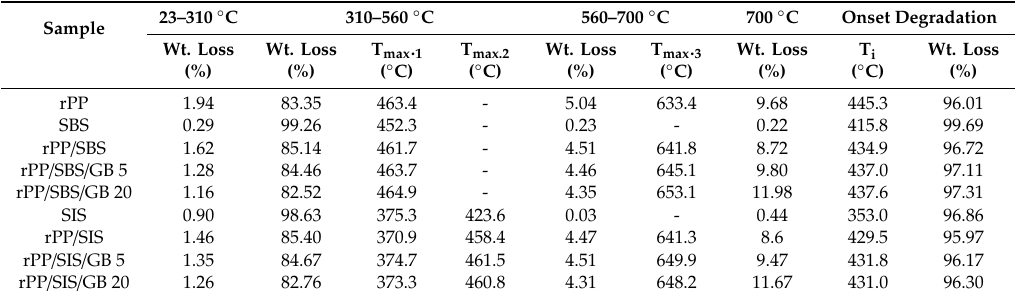
Table 5. Degradation temperature, weight loss, and residue for different post-consumer rPP composites.